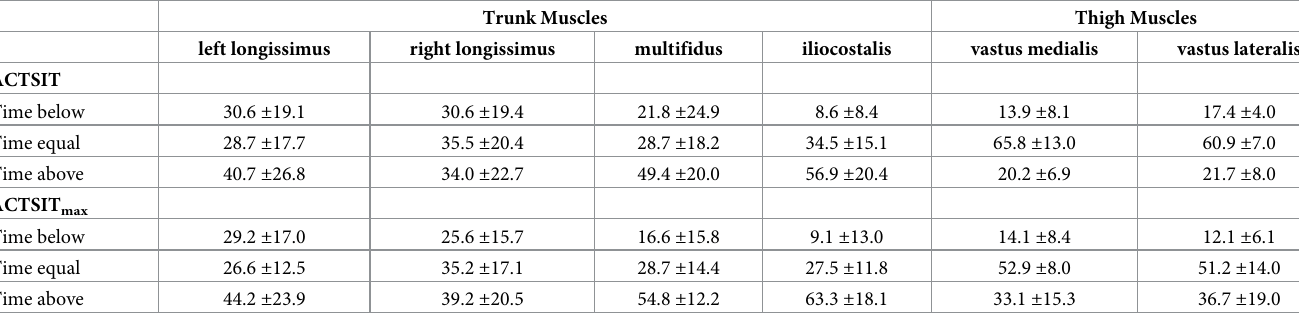
Table 3. Temporal muscular activity pattern.